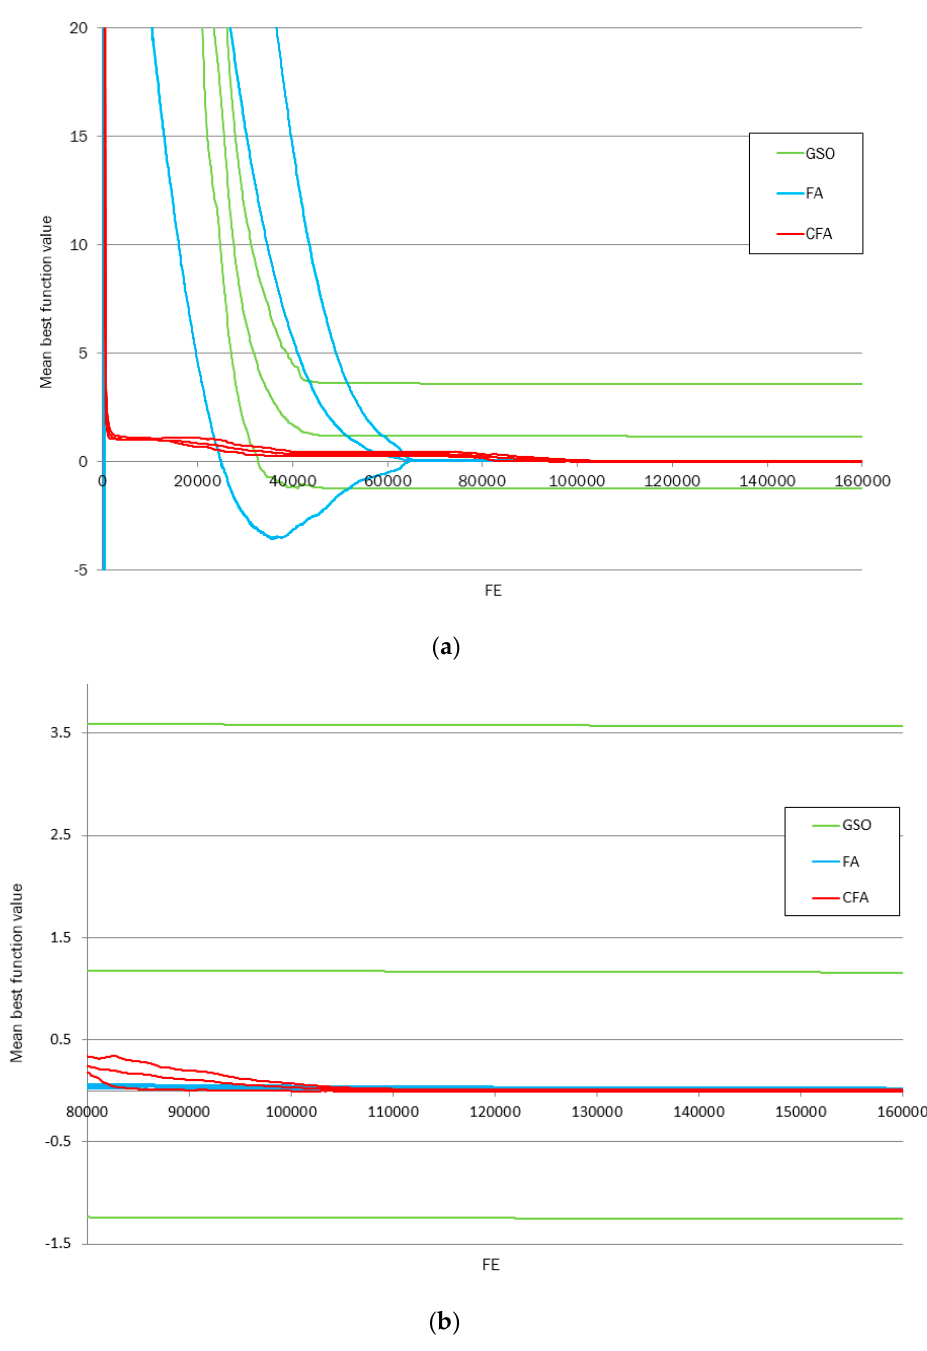
Figure 7. Online performance analysis with 95% confidence interval for the Griewank (30) function. ( a ) The convergence of the best function value during the whole duration of the execution. ( b ) The convergence of the best function value during the second half duration of the execution.